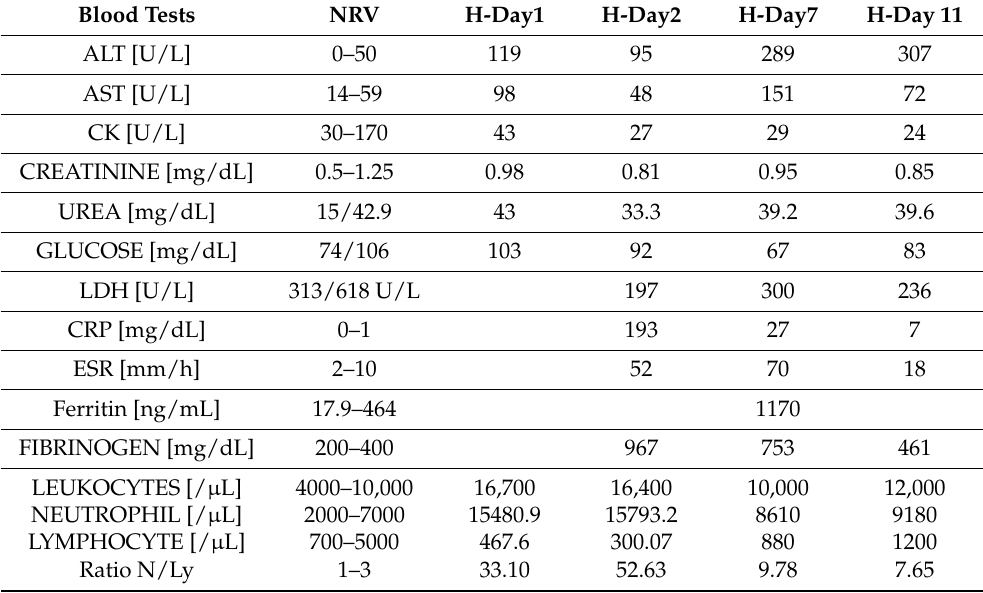
Table A1. Lab results during hospitalization for severe Covid-19 in a 45-years old man patient.